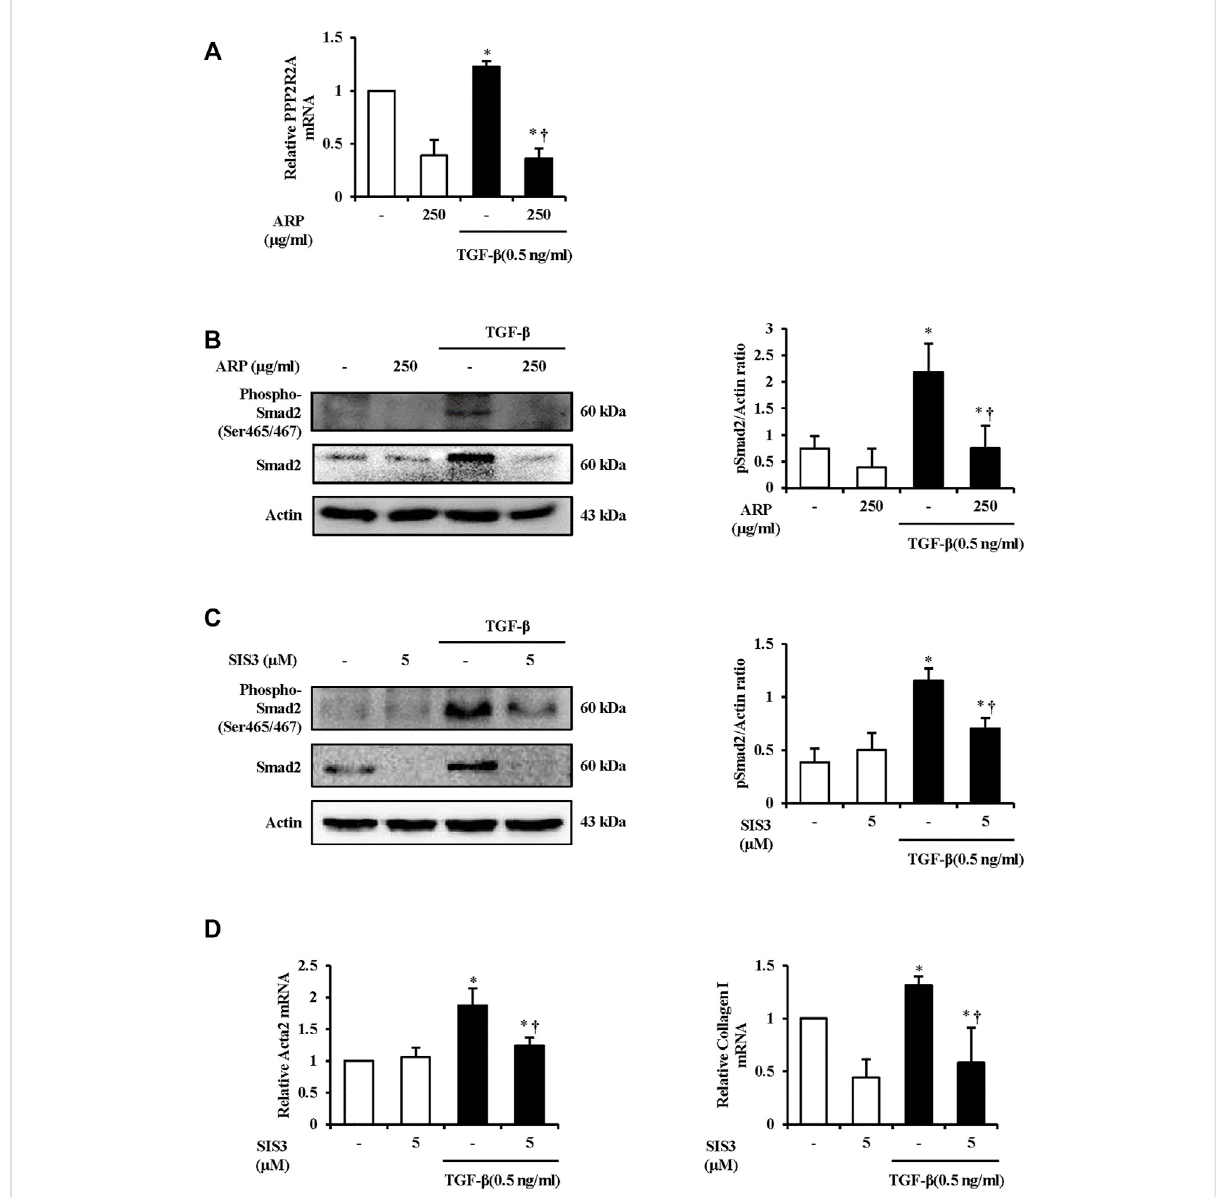
The Mechanism of ARP to Regulate PSC Activation in the Isolated PSCs. (A) TGF- β induced PPP2R2A mRNA levels in isolated PSCs were assessed usingRT-qPCR. (B,C) Proteinexpressionofphosphorylated Smad2